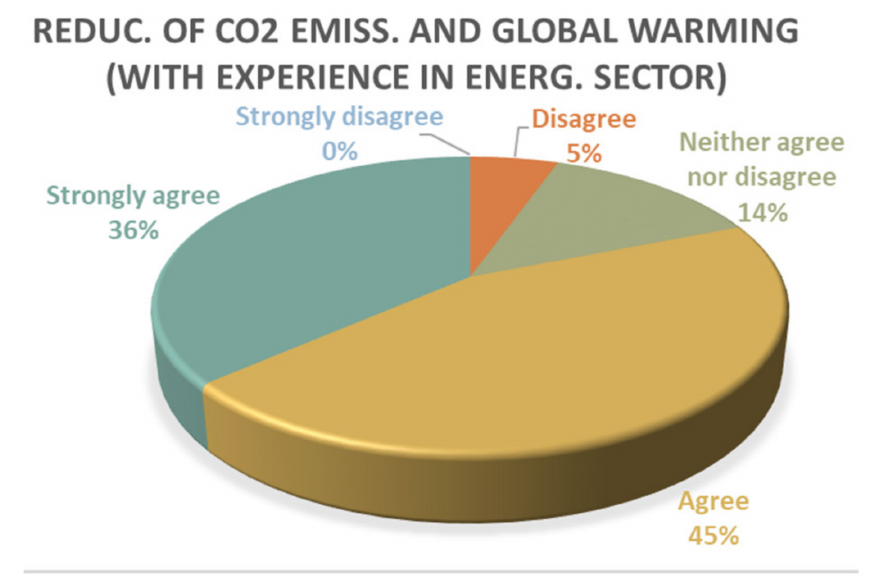
Figure 6. Participation of consumers in DR programs in order to reduce CO 2 and global warming (Consumers WITH experience in Energy Sector). Source: Authors’ own